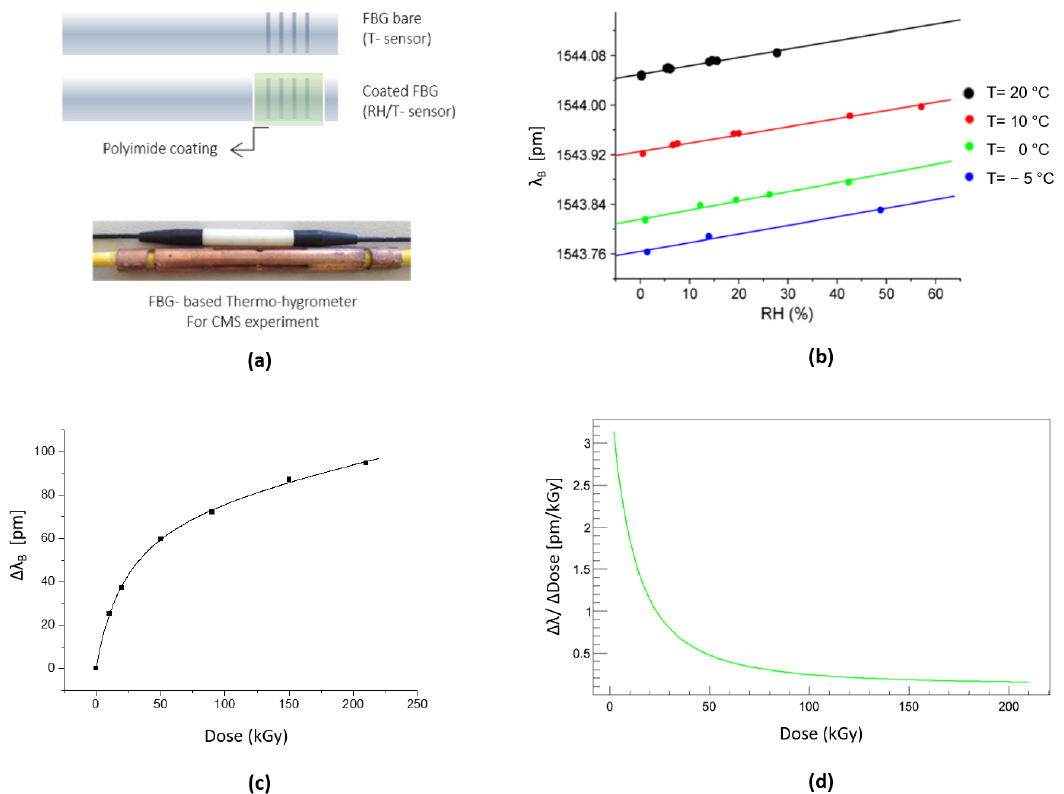
Figure 18. ( a ) FOS thermo-hygrometer based on FBG technology developed for CMS experiment; ( b ) RH characterization at different temperatures; ( c ) Radiation-induced wavelength shift as a function of the total adsorbed dose; ( d ) Radiation sensitivity (Readapted from Ref. [123]).